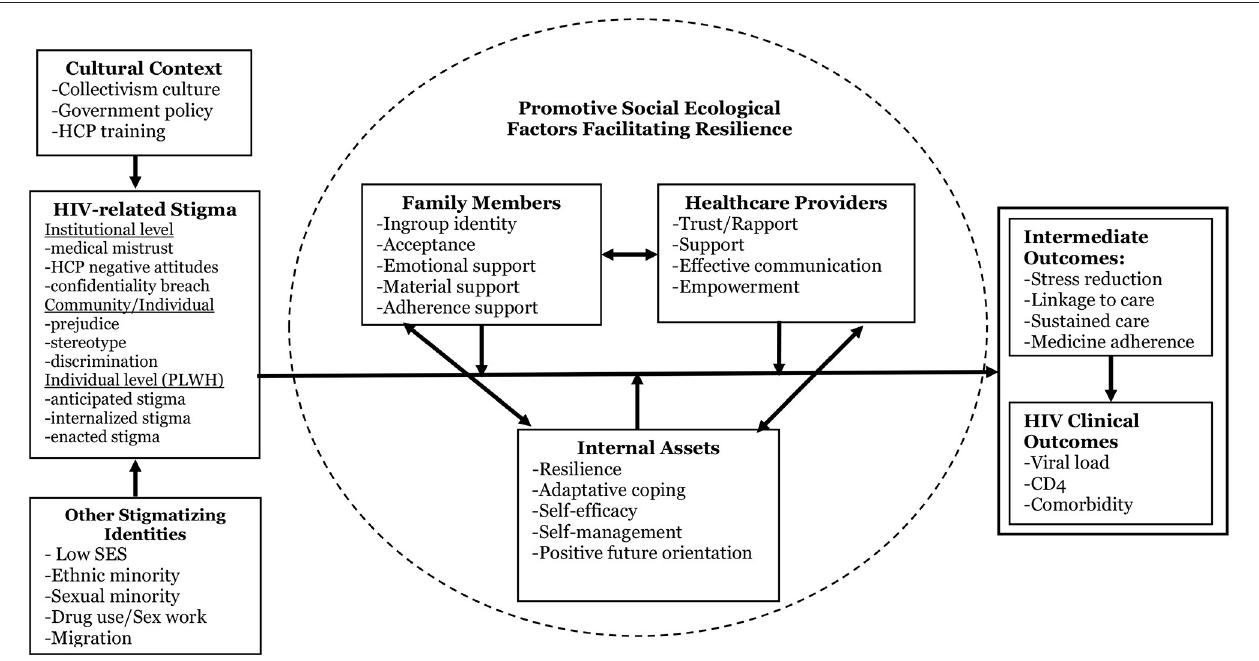
FIGURE 1 | Conceptual framework [adapted from Li et al.